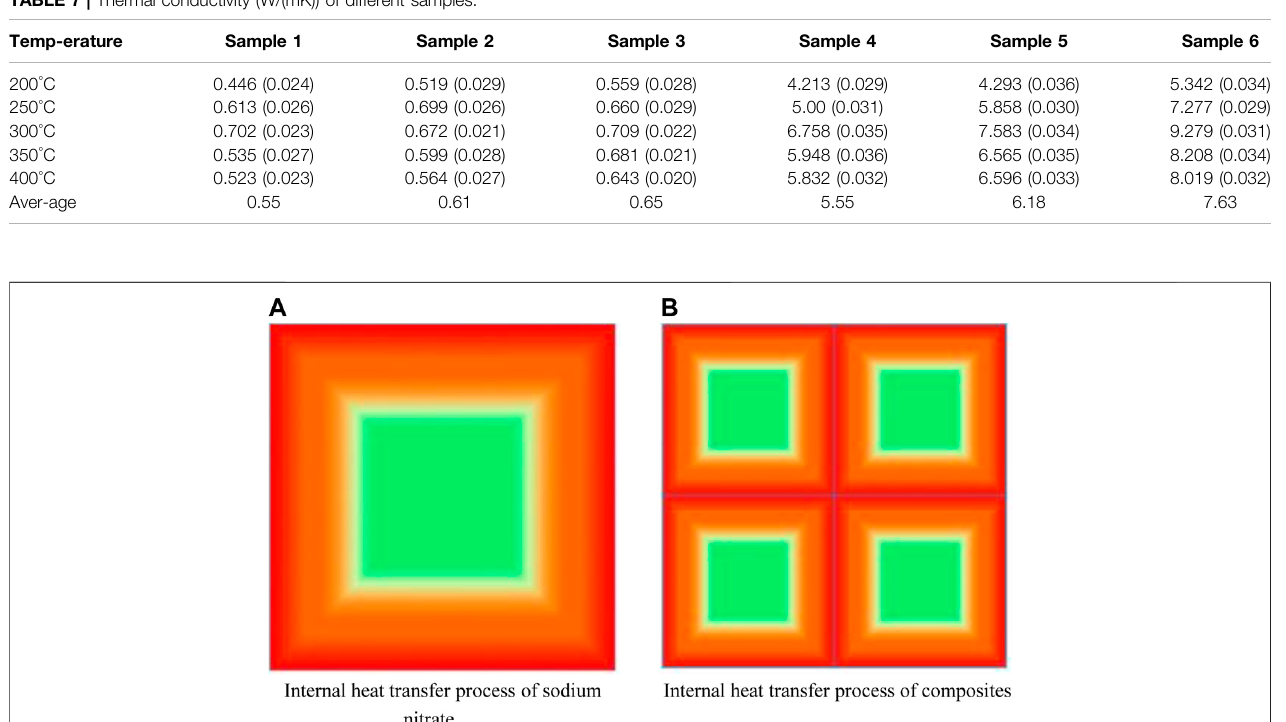
FIGURE 12 | Schematic diagram of the internal heat transfer process of different materials. (A) Internal heat transfer process of sodium nitrate. (B) Internal heat transfer process of composites.